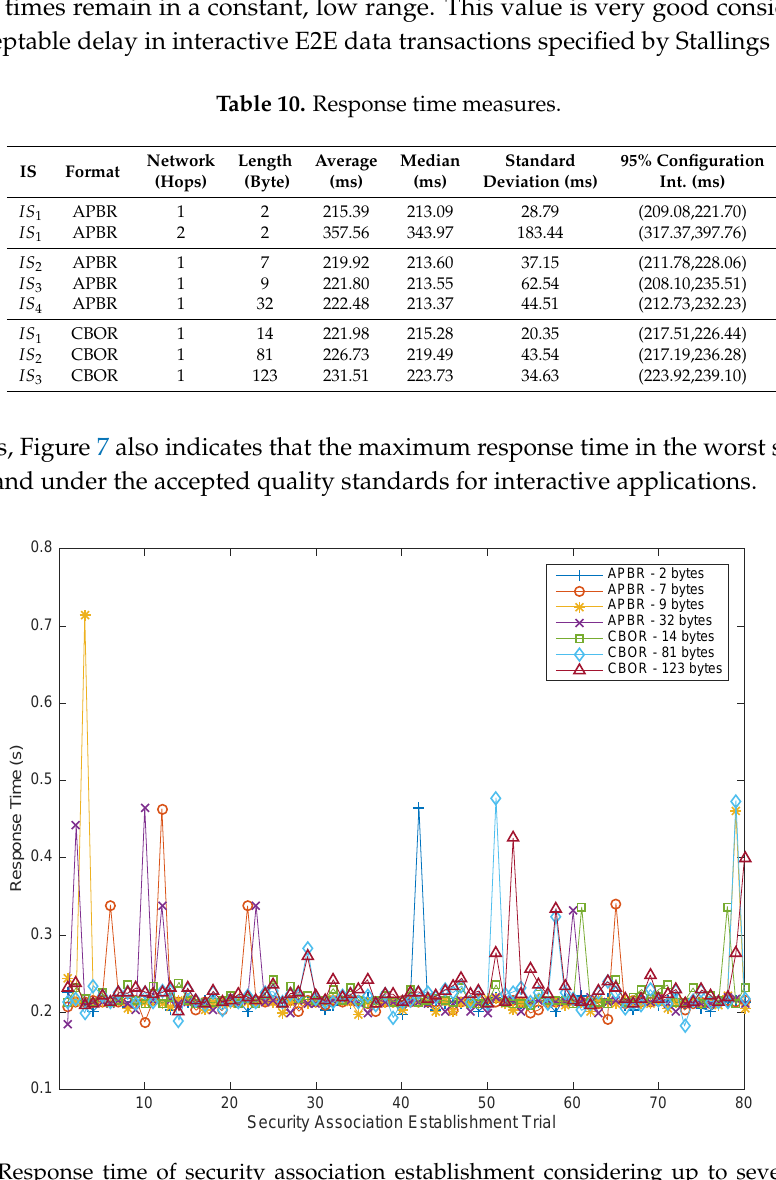
Figure 7. Response time of security association establishment considering up to seven series of 80